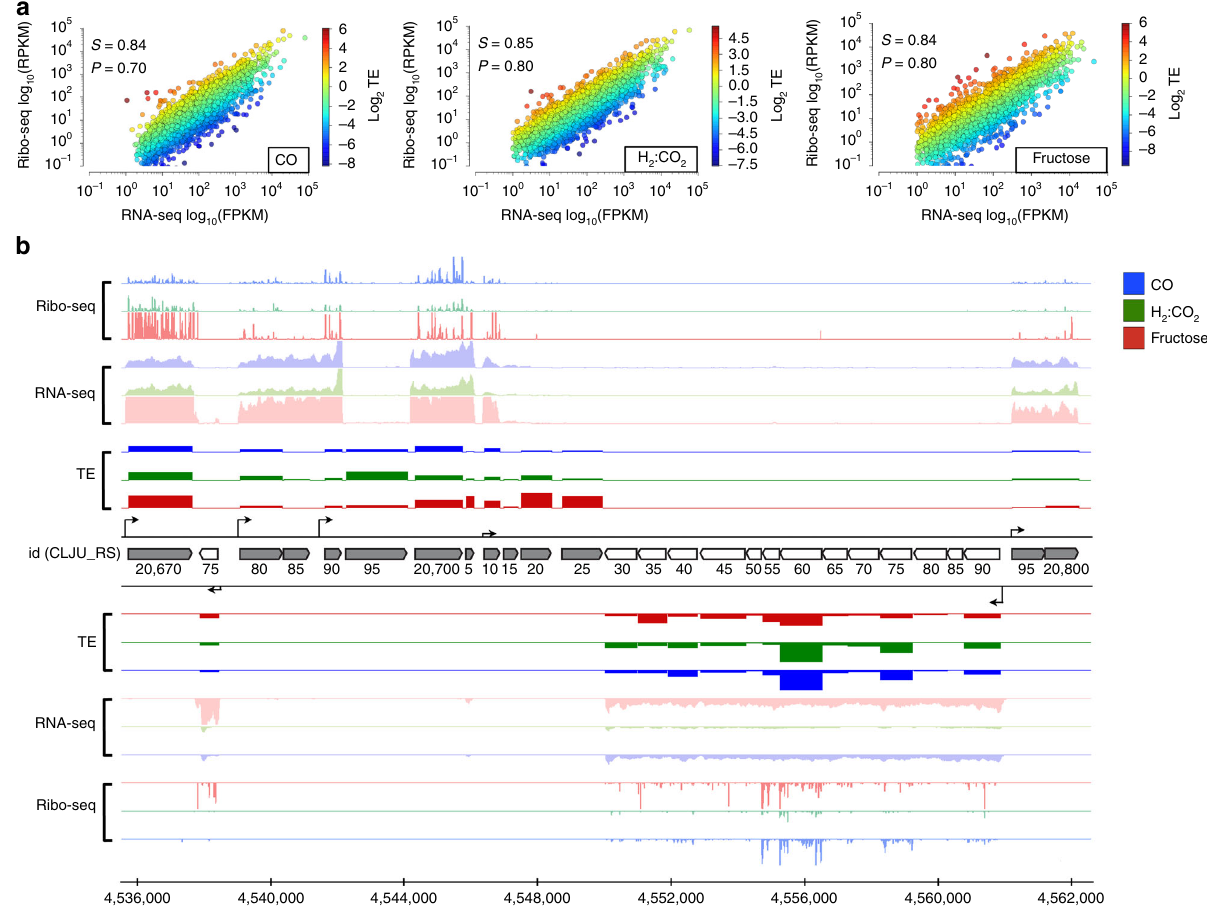
Fig. 1 Overview of omic experiments carried out and the correlation between RNA-seq and Ribo-seq in all growth conditions. a Correlations between RNA-seq and Ribo-seq in CO, H 2 :CO 2 , and fructose. Pearson ’ s ( P ) and Spearman ’ s ( S ) correlation coef fi cients are shown inside each sub fi gure. Colors in the scatter plot represent the translational ef fi ciency values. The color bars show TE log 2 values. b An example of Ribo-seq, RNA-seq, TE, and TSS pro fi les mapped onto genomic region between 4,535,800 to 4,564,000 and showing genes Clju_RS20670 to Clju_RS20800 . RNA-seq and Ribo-seq pro fi les were normalized to reads per million (RPM). TE of each gene is a ratio Ribo-seq to RNA-seq level. Arrows indicate transcription start site (TSS) positions